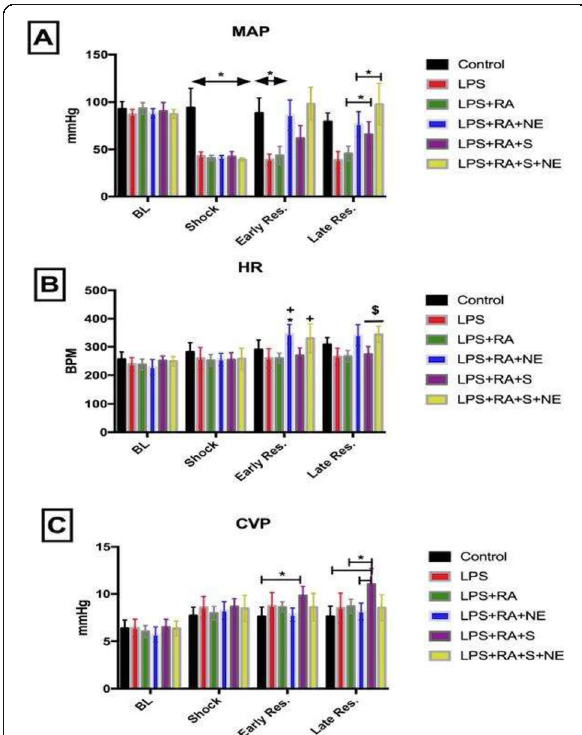
Fig. 1 (abstract 0161). Values of MAP, HR and CVP throughout experiments Fig. 3 (abstract 0161). Lactate, SaO2, PaO2 and PaCO2